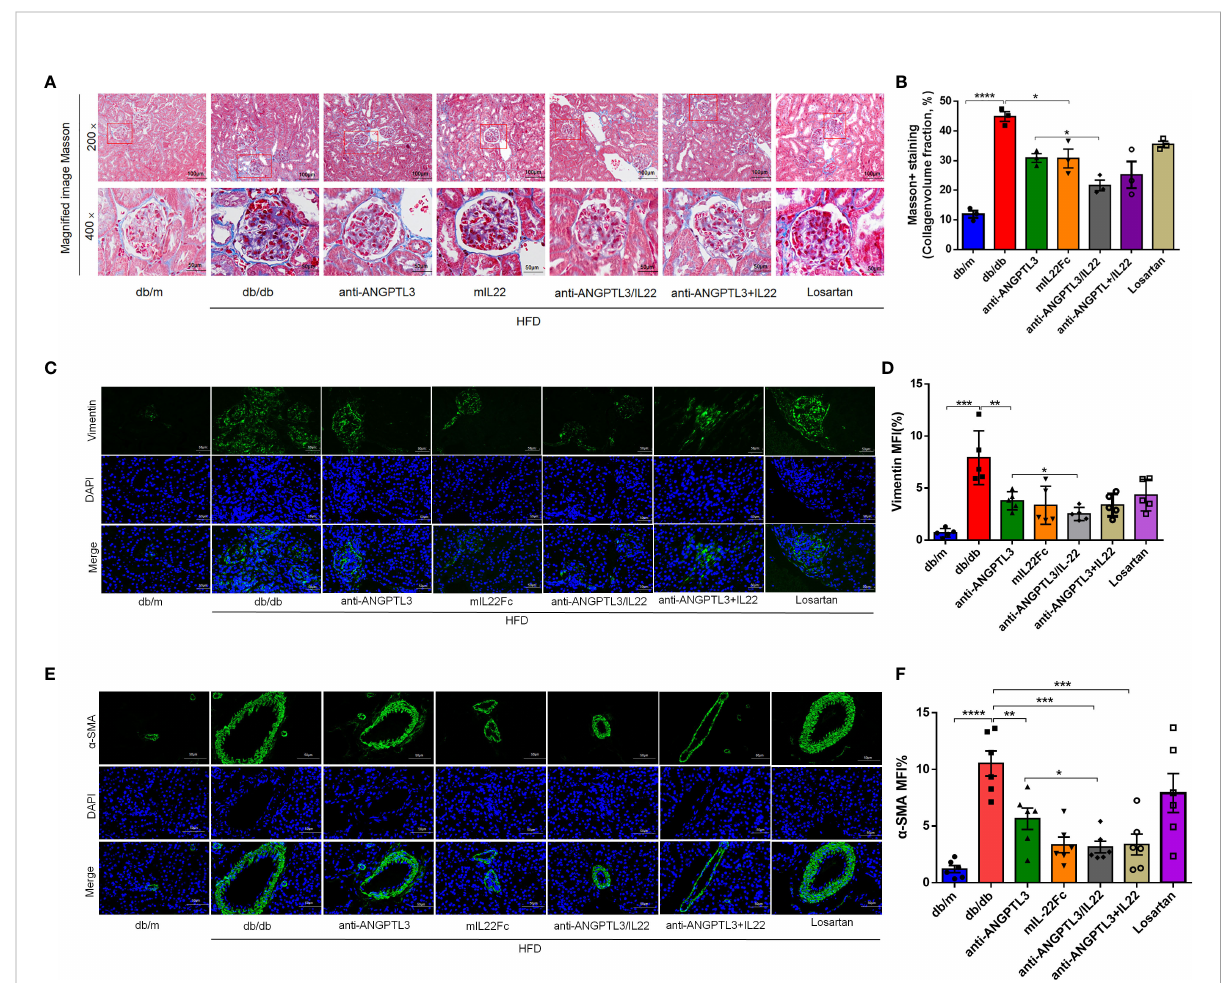
FIGURE 5 Anti-ANGPTL3/IL22 fusion protein reduced renal fi brosis in db/db mice. (A) Representative Masson staining images of mouse kidney tissues after 8 weeks of anti-ANGPTL3/IL22 treatment. (B) Measurements of Masson-positive staining. (Scale bar: 100 m m, 200 ×; 50 m m, 400 ×). (C) The levels of vimentin in the kidney sections were measured by immuno fl uorescence. (Scale bar: 50 m m). (D) Statistical assessment of vimentin expression in the kidney sections. (n = 5). (E) The levels of a -SMA in the kidney sections were measured by immuno fl uorescence. (Scale bar: 50 m m). (F) Quantitative analysis of a -SMA expression (n = 6). * P < 0.05; ** P < 0.01; *** P < 0.001 ;